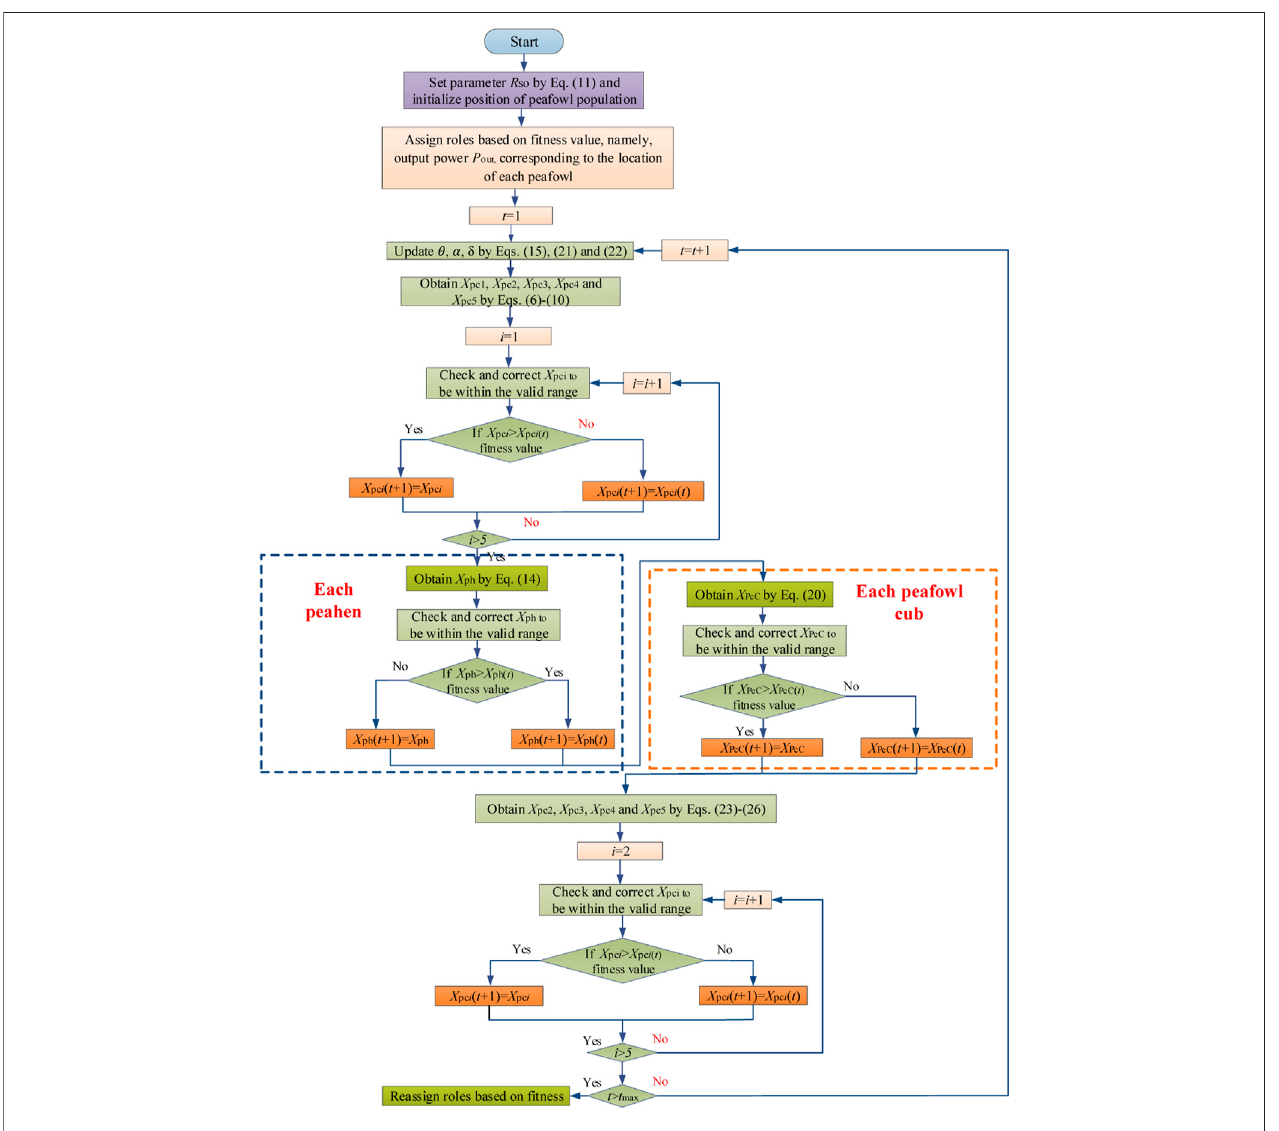
FIGURE 4 | Entire execution fl owchart of FOA for MPPT of PV systems under PSC.